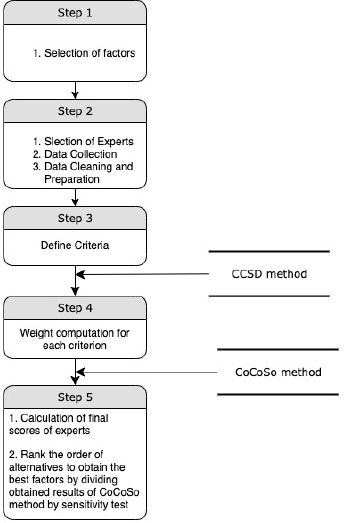
Fig. 3. Overall procedure for expert’s section and ranking of alternatives, Source: Authors. Created by Draw.io Software